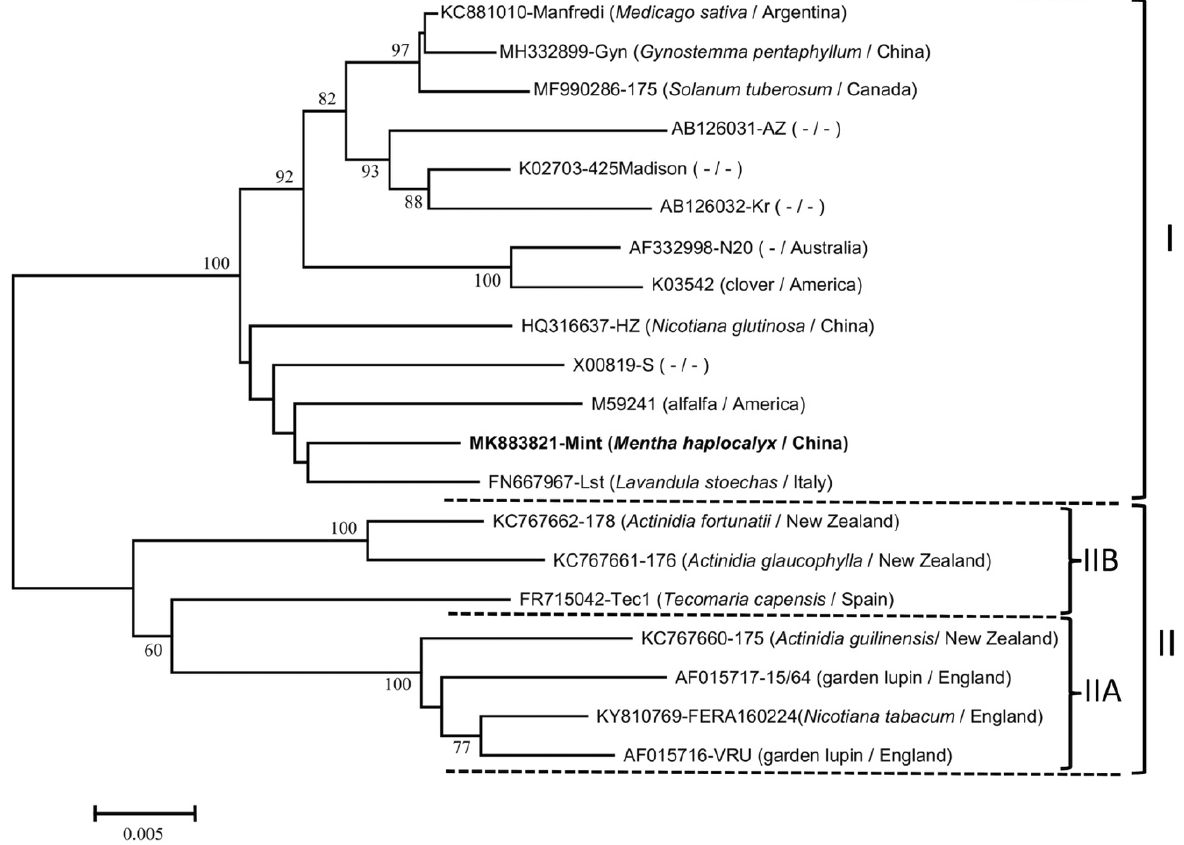
Figure 3. Phylogenetic analysis using the neighbour-joining method, based on RNA3 sequences of AMV isolates. Different groups are indi- cated and separated by dotted lines. AMV-Mint from the present study is indicated in bold